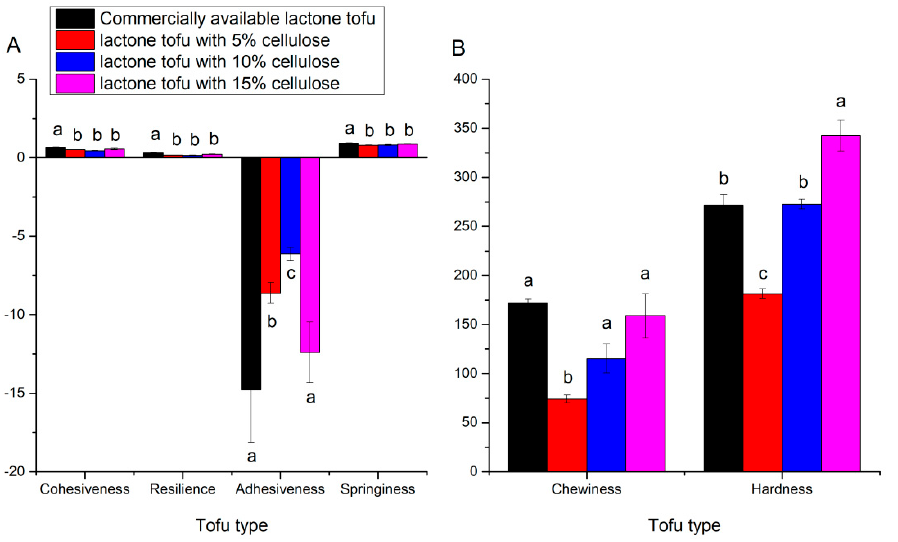
Figure 4. Analysis of full texture of different tofu types. ( A ) represent the texture properties of co- hesiveness, resilience, adhesiveness, and springiness. ( B ) represent the texture properties of chewiness and hardness.